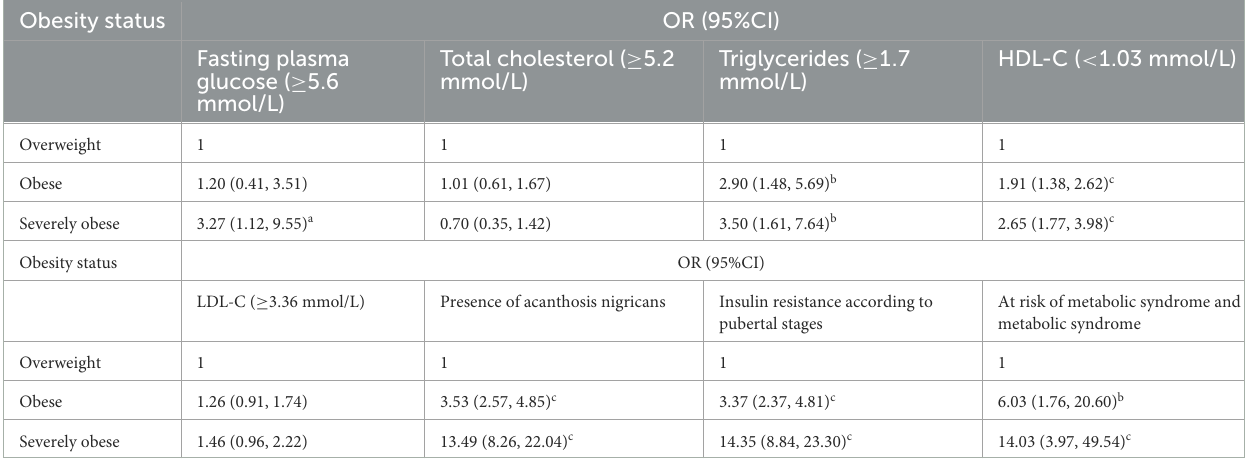
TABLE 4 Association between cardiometabolic risk factors and obesity status. Obesity status